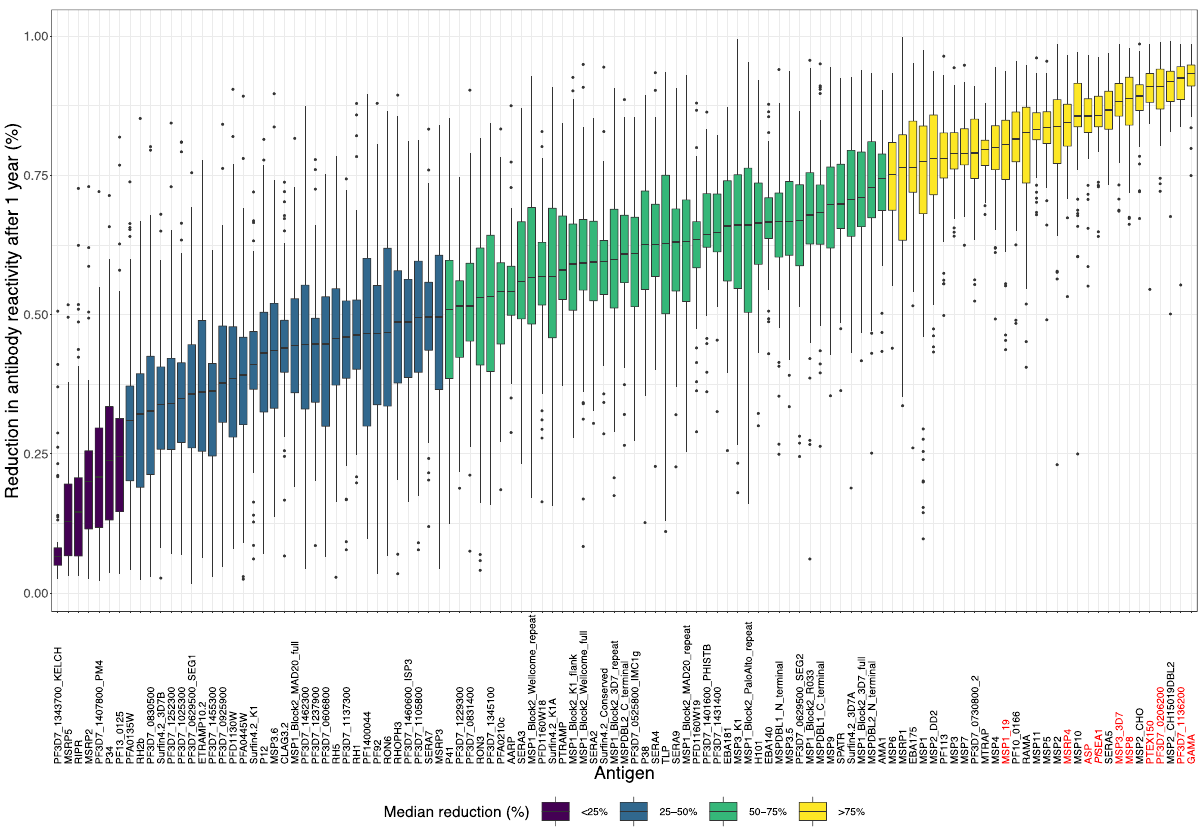
Fig. 6 Box-plot of individual antigen-speci fi c antibody kinetic model-estimated relative reduction (%) in antibody levels after one year of follow-up. The antibody kinetic model was fi tted separately to data on each antibody response measured in 240 longitudinally collected samples from 65 unique study participants. Responses are ordered from left to right by smallest to largest relative reduction in antibody levels. The individual responses identi fi ed as top 10 most informative in detecting recent infection based on a threshold antibody level to a single antigen are highlighted in red. The colour of the box indicates whether the median relative reduction in antibody levels over one year for a particular response is <25% (purple), 25 – 50% (petrol), 50 – 75% (green), or >75% (yellow). The centres of boxes correspond to the median. The lower and upper hinges of boxes correspond to the fi rst and third quartiles of the data. The upper and lower whiskers extend from the hinges to the largest and smallest values, respectively, no further than 1.5 * the interquartile range from the hinges. Data beyond the end of the whiskers are plotted